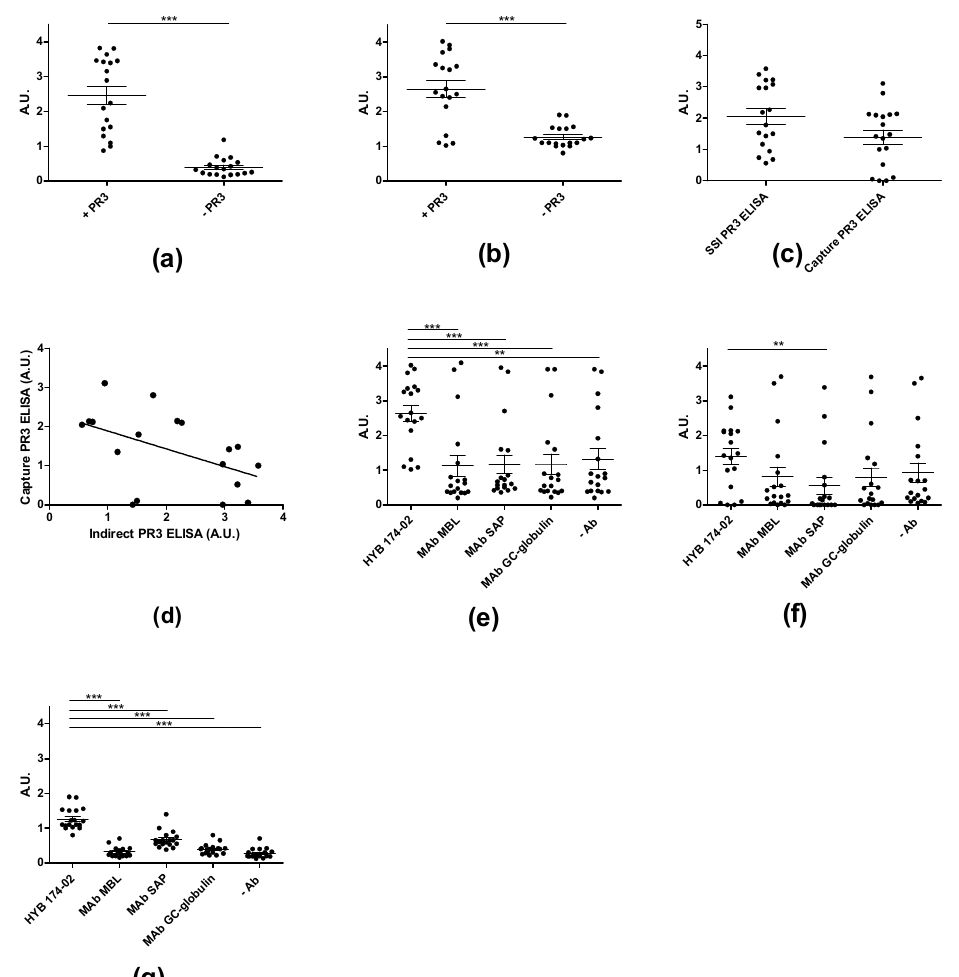
Figure 11. Screening of GPA patient sera binding to PR3 (SSI) by ELISA. ( a ) Detection of autoantibodies in GPA patient sera to PR3 in indirect ELISA, where wells were coated with or without SSI PR3. ** p < 0.01, *** p < 0.001. ( b ) Detection of autoantibodies by capture ELISA using HYB 172-04 as capturing antibody. ( c ) Comparison of indirect ( a ) versus capture ELISA ( b ) for detection of PR3 antibodies. ( d ) Correlation analysis between indirect ( a ) and capture ELISA ( b ). ( e ) PR3 capture ELISA with irrelevant control MAbs. ( f ) Background subtracted PR3 capture ELISA with irrelevant control MAbs. ( g ) PR3 capture ELISA without the presence of PR3 with irrelevant control MAbs.